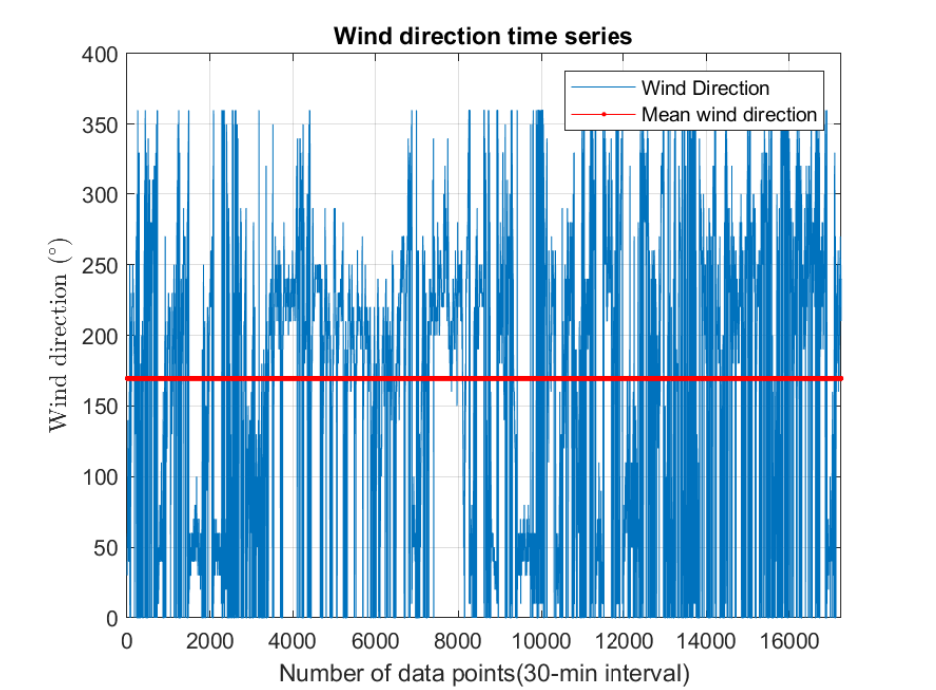
Figure 15. The portraits of wind direction (north direction = 0 ◦ ) in OSWFs in Yangshan port, Shanghai from 22 August 2017 to 22 August